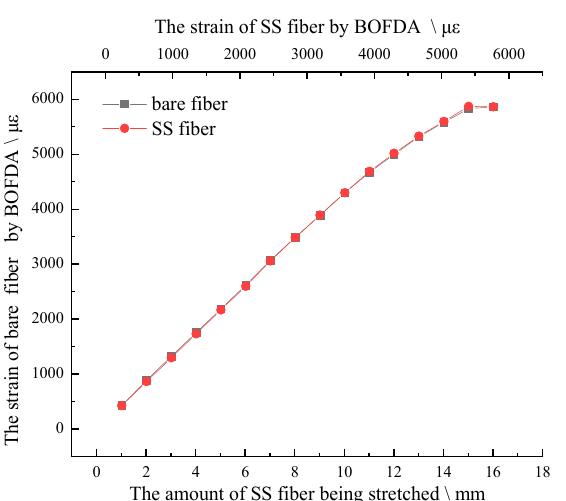
Figure 17. Comparison of strain curves between bare fiber and SS fiber.